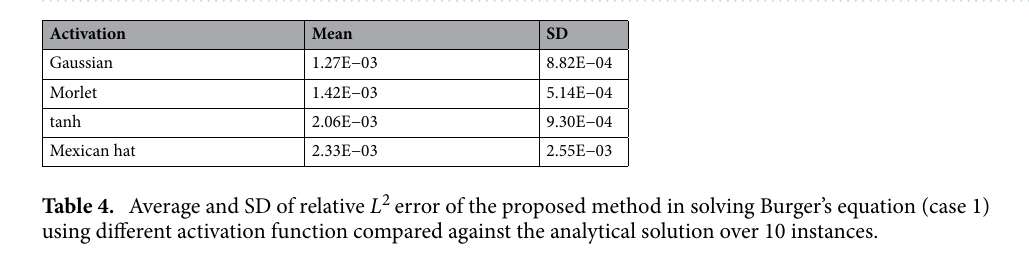
Figure 14. Epoch versus Loss of the proposed method against ‘tanh’ over 10 instances for the Burger’s equation.